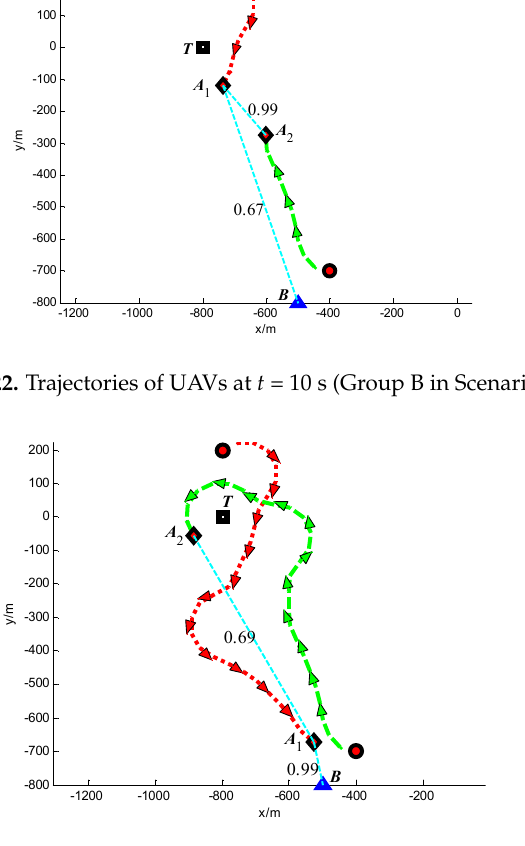
Figure 23. Trajectories of UAVs at t = 20 s (Group B in Scenario 2).